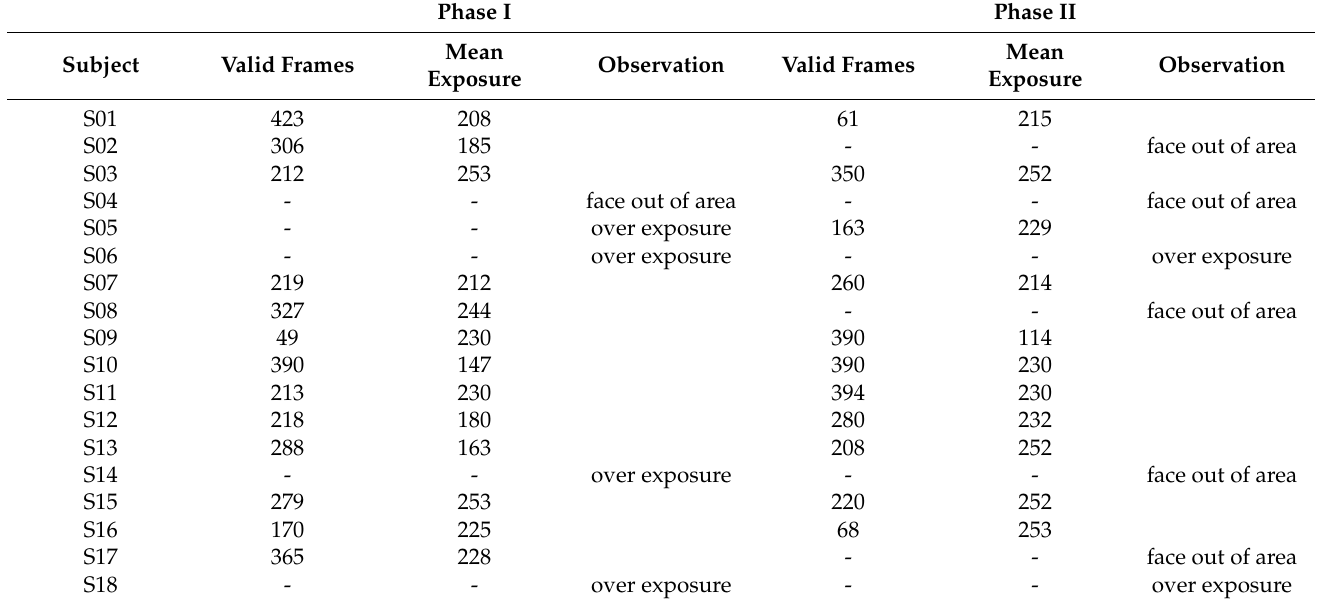
Table 2. Overview of valid frames and achieved mean facial exposure for each subject and recording